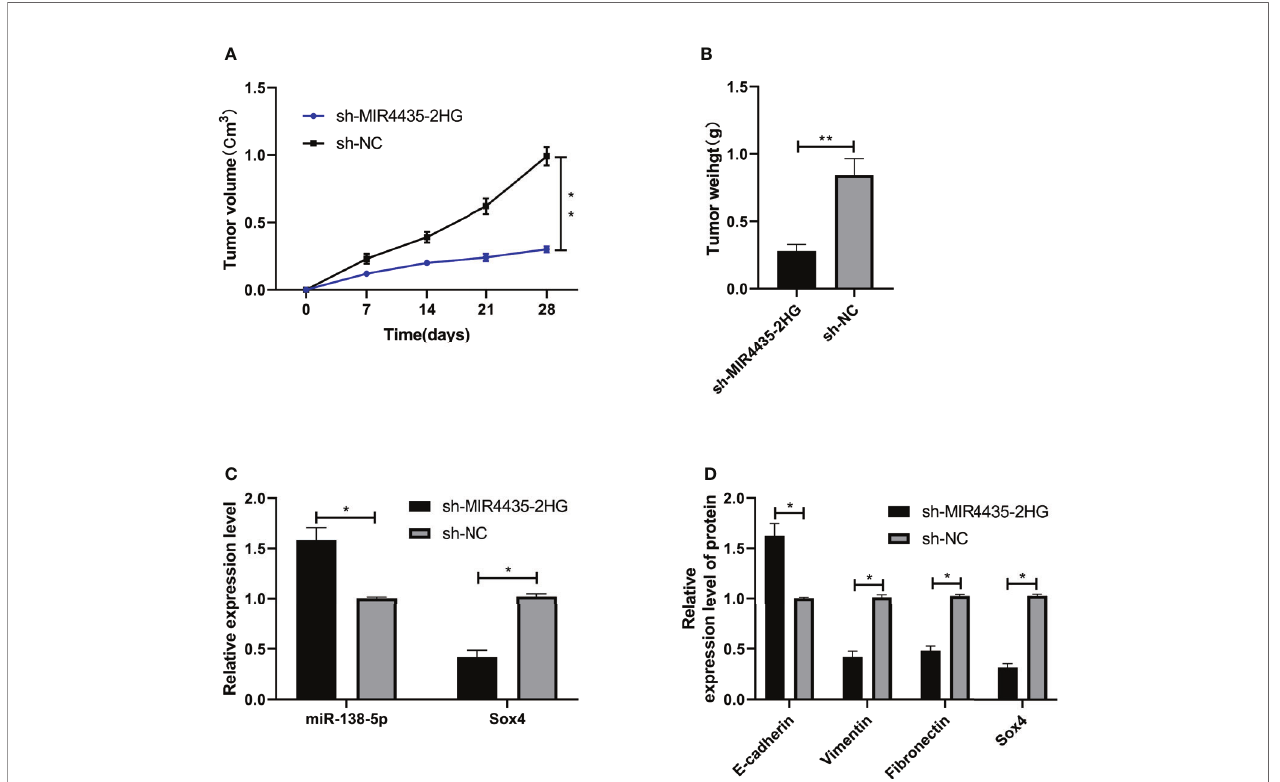
FIGURE 6 | MIR4435-2HG inhibited epithelial – mesenchymal transition (EMT) of gastric carcinoma through miR-138-5p/Sox4 axis. (A, B) sh-MIR4435-2HG inhibited the growth of gastric carcinoma in nude mice tumors. (C) qRT-PCR was applied to test miR-138-5p and Sox4 in nude mice tumors. (D) Western blotting (WB) was applied to test E-cadherin, vimentin, fi bronectin, and Sox4 protein in nude mice tumor. * indicates p < 0.05; ** indicates p <